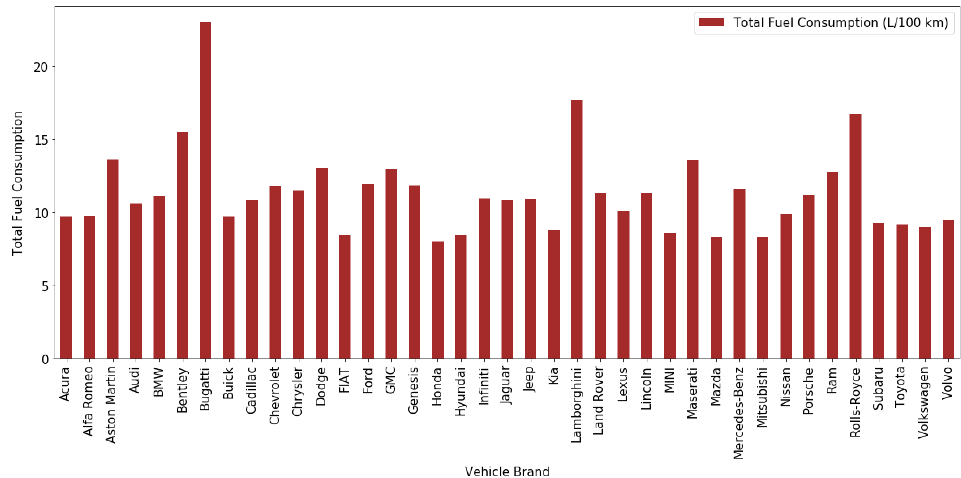
Figure 2. Total fuel consumption (L/100 km) of each